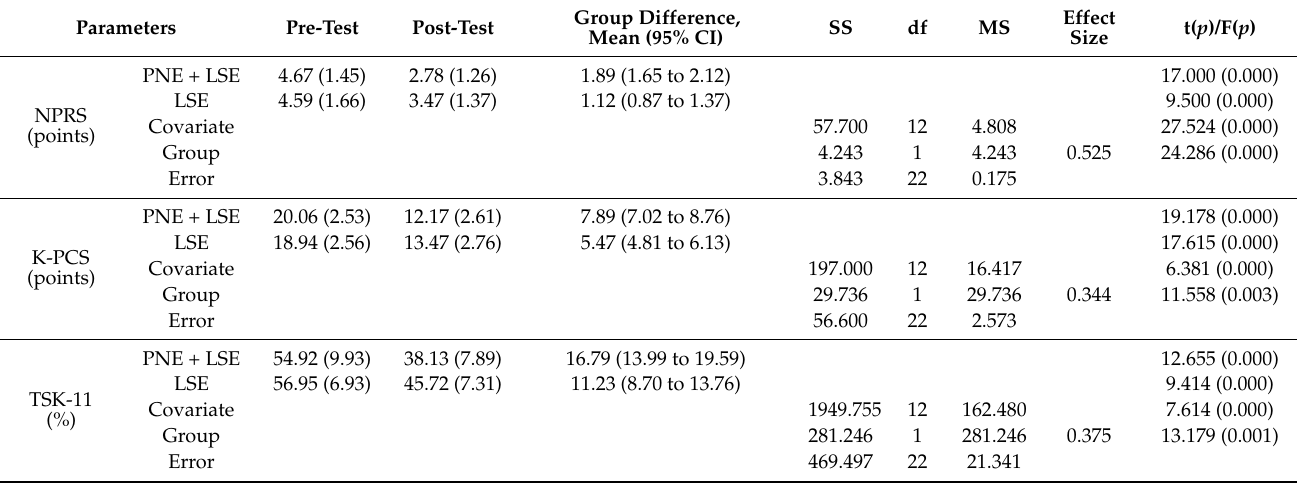
Table 5. Comparison of pain within groups and between groups ( N = 35).